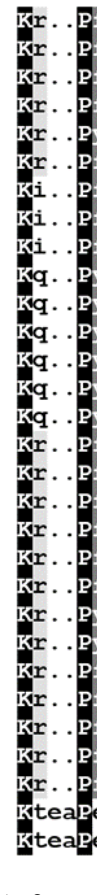
Figure 5. Logo plots of Sox protein sequences displaying the most conserved domain and positions of amino acids. A total of 26 multiple sequence alignments are represented using Weblogo (http://weblogo.berkeley.edu/logo.cgir accessed on 24 April 2022). The relative frequency of the amino acids is shown on the y ‐ axis. 3.4. Conserved Motif Analysis of Sox Genes To further characterize the evolutionary pattern of the Sox gene in the Bos species, a conserved motif analysis was performed using the MEME and MEGA programs. The re ‐ sults indicate that 10 conserved motifs are present in the Bos species. Interestingly, we found that conserved motifs 1 and 2 (M1 and M2) exist in all members of the Sox family except Sox 17, which had motif 1 only. The other nine motifs were present in the different Sox groups. M1 and M2 are the core HMG boxes, containing 79 amino acid residues. As shown, five motifs are present in Sox D— sox 13 and Sox E: Sox 9 and 10, and seven motifs in Sox D: Sox 5 (Figure 6a). Four motifs exist in Sox E: Sox 8 and three motifs in Sox H: Sox 30. In ‐ terestingly, we found an importantly conserved motif, namely, EFDQYL/ELDQYL, in both Sox E and F including Sox 7–10 and 18 with the exception of Sox 17 (Figure 6b). This motif is crucial for the transactivation and regulation of these protein family and has also been observed in humans.